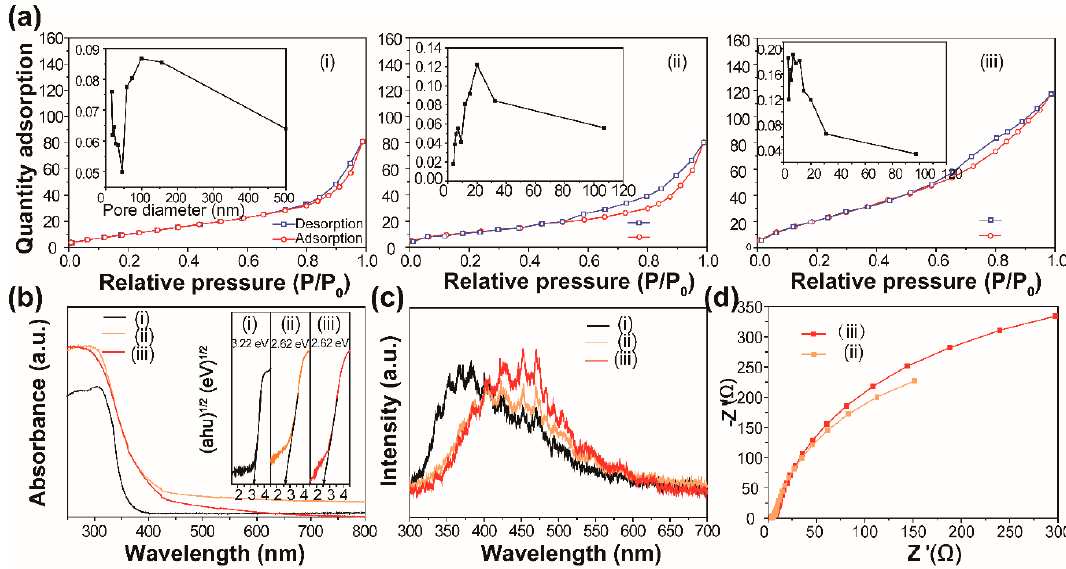
Figure 6. ( a ) Brunner − Emmet − Teller (BET) surface area analysis, ( b ) UV-vis diffuse reflectance spectra and ( c ) Photoluminescence (PL) of the as-prepared samples: (i) BiOCl, (ii) BiOCl/Bi 2 WO 6 and (iii) Bi 2 WO 6 . Insets (a) and (b) are the corresponding pore size distribution and band gap energies of the prepared samples, respectively. ( d ) The electrochemical impedance spectra (EIS) spectra of (ii) BiOCl/Bi 2 WO 6 and (iii) Bi 2 WO 6 .